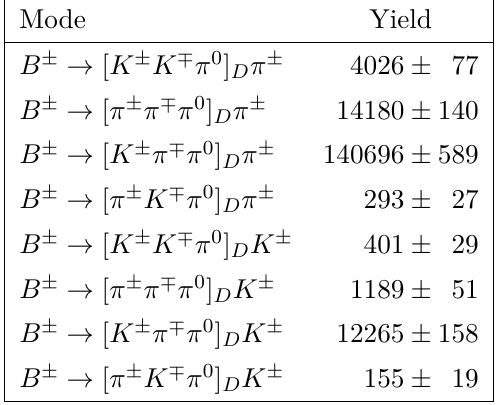
Table 1 . Signal yields for each decay mode. The uncertainties quoted are statistical